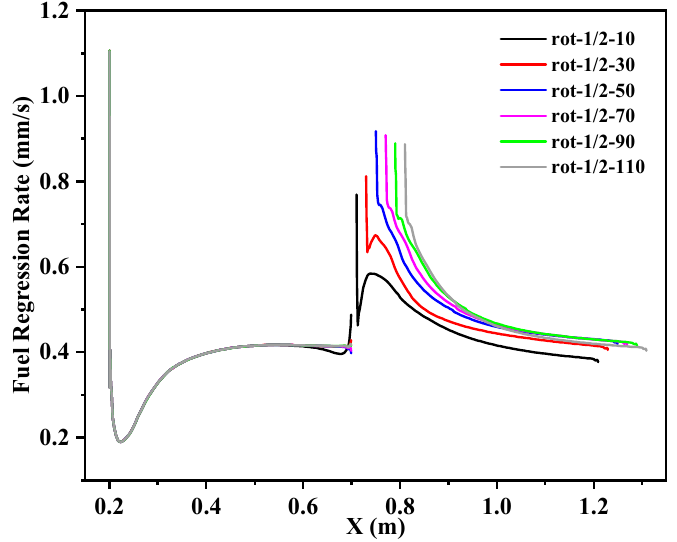
Figure 24. Fuel regression rates of point c along the motor axis in cases with various mid-chamber lengths.